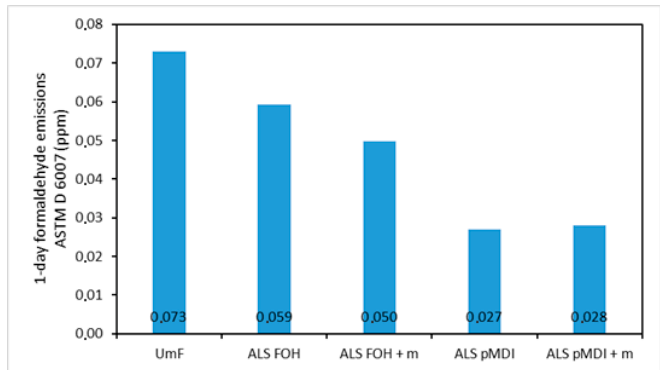
Figure 9 Figure 9. Formaldehyde emissions of particleboards produced with urea-melamine-formaldehyde (UmF), ammonium lignosulfonate (ALS) crosslinked with furfuryl alcohol (ALS FOH), ALS FOH with mimosa tannin (ALS FOH + m), ALS crosslinked with pMDI (ALS pMDI) and ALS pMDI with mimosa tannin (ALS pMDI + m).